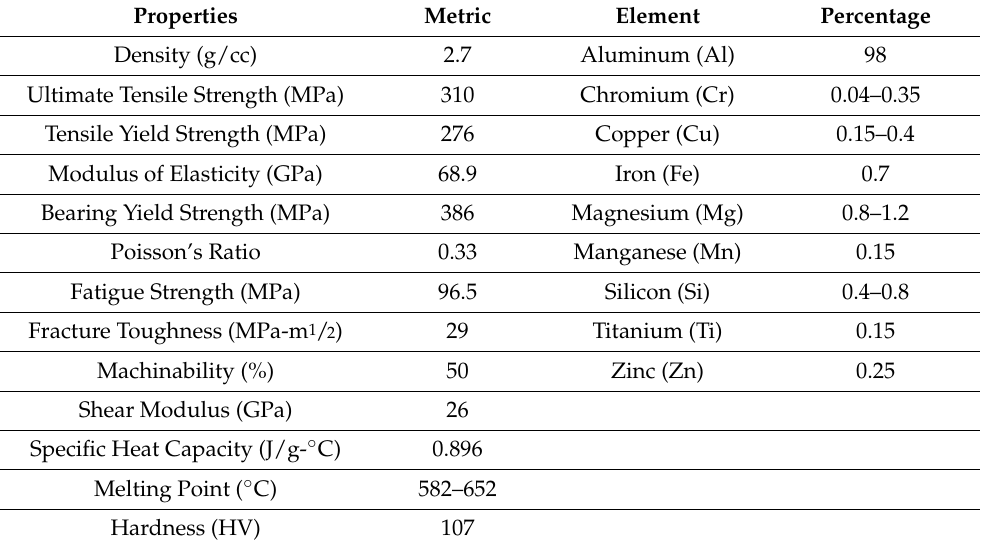
Table 2. Al6061-T651 alloy material properties Adapted with permission from ref. [36]. Copyright 2017 Elsevier, and component element properties Adapted with permission from ref. [37]. Copyright 2012